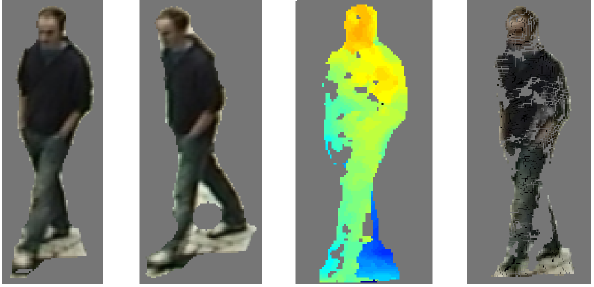
Figure 3: Input to dense matching (left), colour-coded disparity map (center) and coloured point cloud (right).